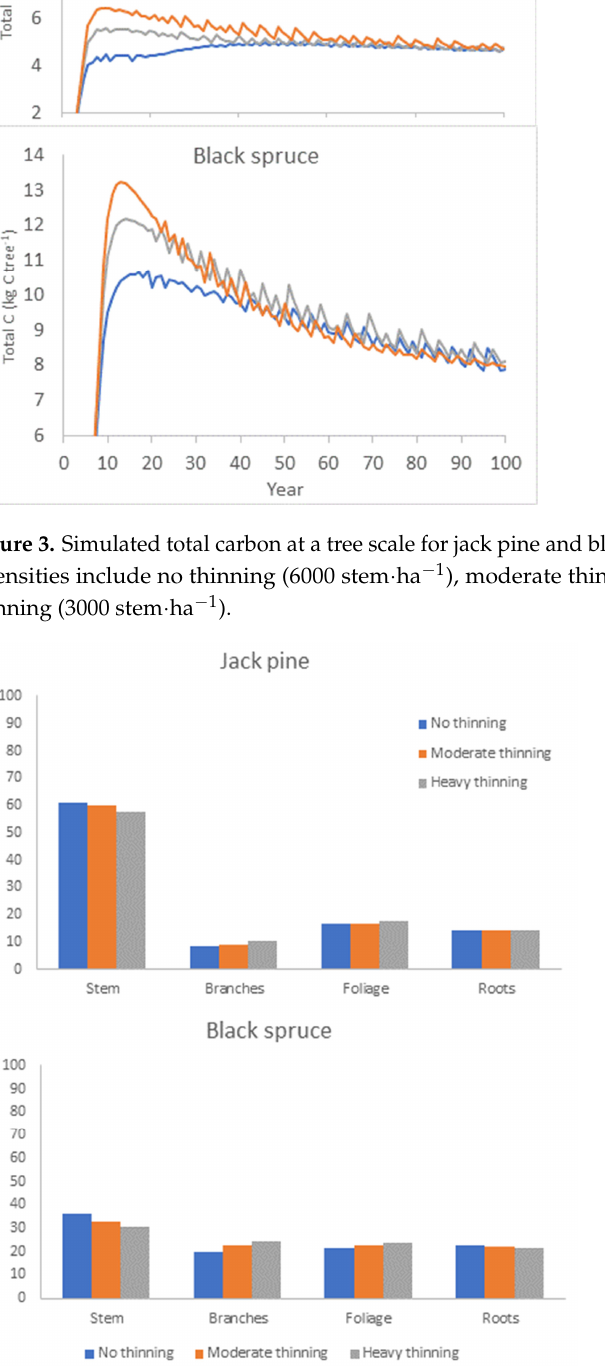
Figure 4. Simulated carbon allocation in foliage, branches, stem, and roots, relative to total carbon at a tree scale for jack pine and black spruce. The simulated thinning intensities include no thinning (6000 stem·ha − 1 ), moderate thinning (4000 stem·ha − 1 remaining in the stands), and heavy thinning (3000 stem·ha − 1 remaining in the stands). Carbon allocation in the stem (C stem ), branches (C branches ), foliage (C foliage ), and roots (C roots ) for different thinning intensities showed different patterns according to thinning